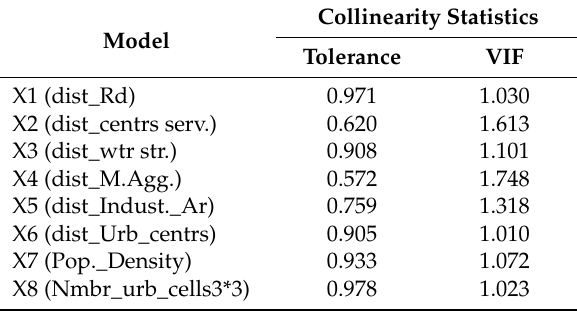
Table 5. Results of multicollinearity analysis.